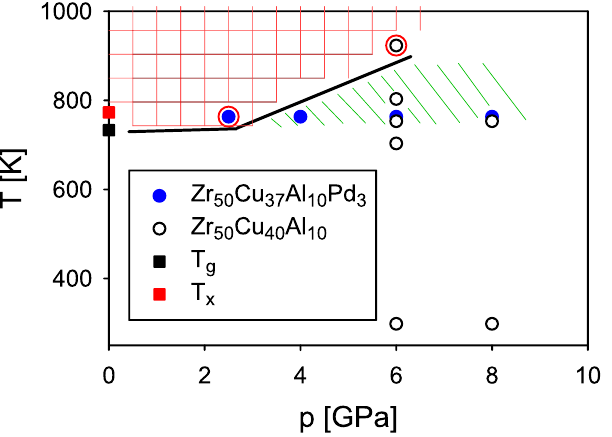
Figure 1. The T-P range explored by quenching the supercooled liquid state. Red circle indicates a nanocrystalline state. Black and red squares denote the glass transition and crystallization temperatures measured during heating at ambient pressure in the DSC for the as cast sample. The red area above the black line indicates where crystallization occurs. The green area indicates the range where the high-pressure structure was